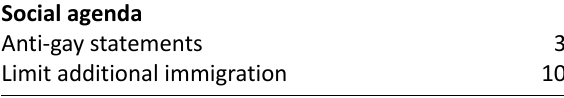
Table 3. Themes raised during the Rob Ford campaign (number of times mentioned). Source: articles mention- ing Rob Ford in the Toronto Star (2010) and Globe and Mail (2010) published between September 10 and Octo- ber 25, 2010.